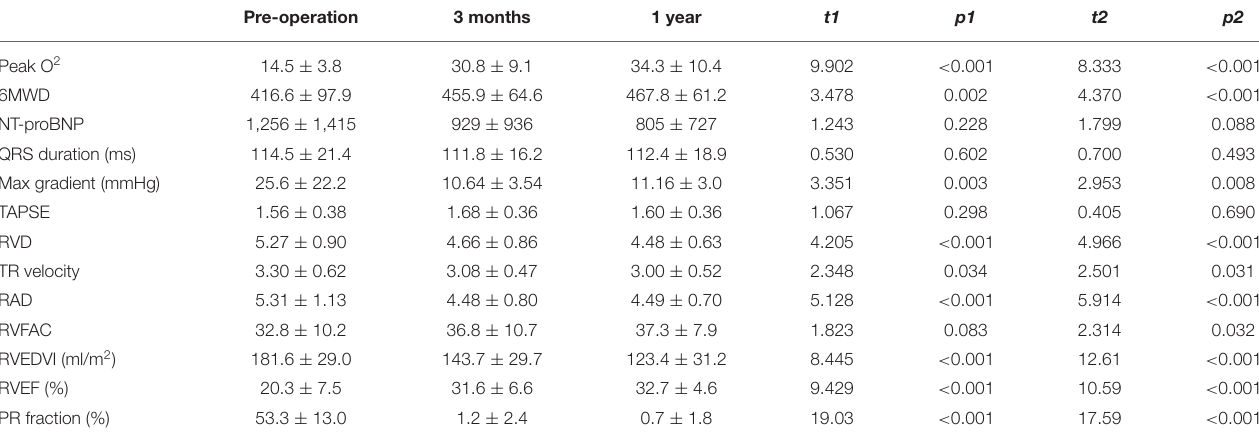
TABLE 4 | Data of pre-operation, 3-months and 1-year